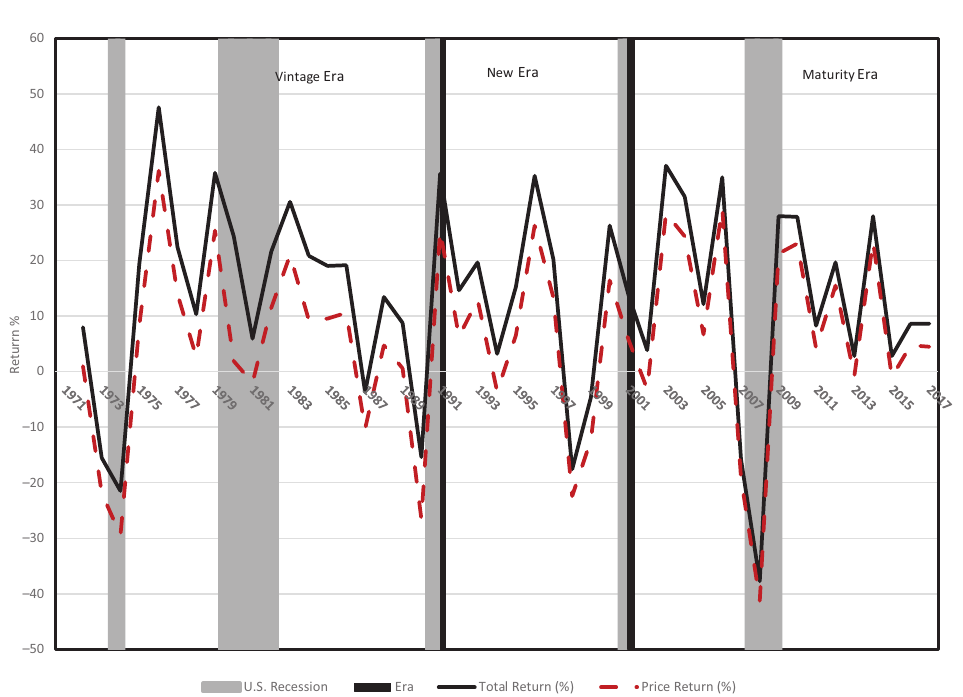
Panel B: Annual total and price returns on the FTSE-NAREIT All Equity REIT Index